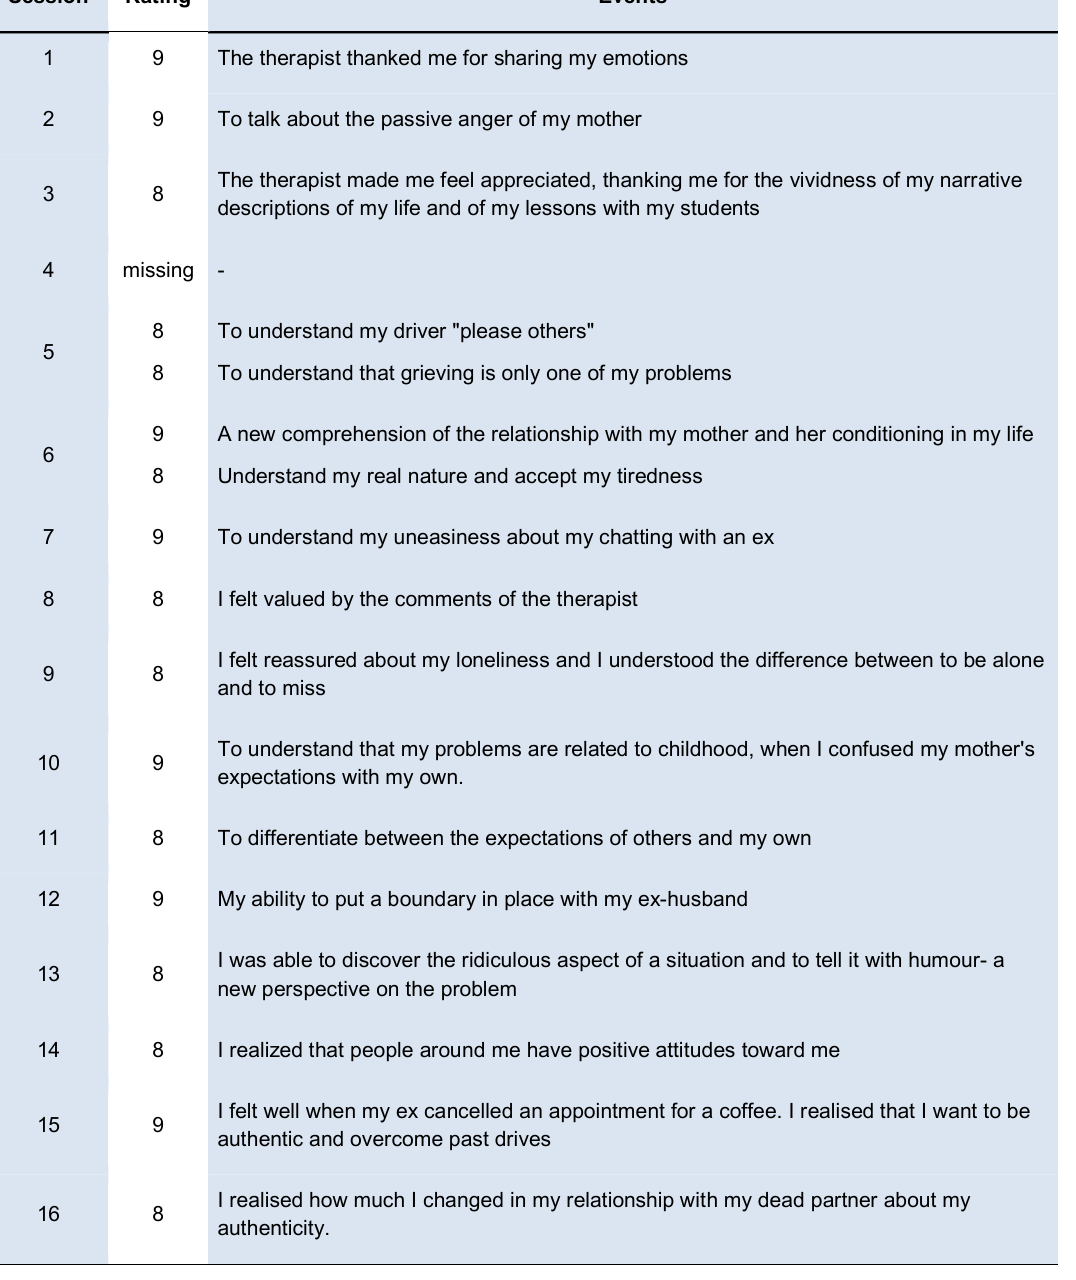
Table 4: Sara's helpful aspect of therapy (HAT forms) Note. The rating is on a scale from 1 to 9; 1 = extremely hindering, 9 = extremely helpful. HAT = Helpful Aspect of Therapy (Llewelyn,